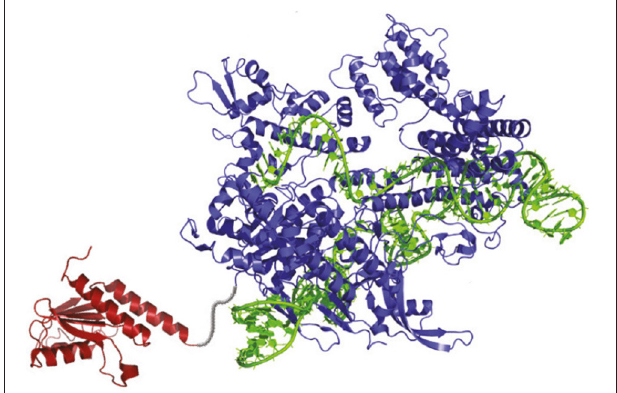
FIGURE 1 | The Structure of the Adenine Base Editor (ABE). The ABE contains an atom-rearranging enzyme (in red) that can convert adenine to inosine (read and copied as guanine), sgRNA (in green), which directs the molecule to the desired point, and a Cas9 nickase (in blue), which snips the opposing strand of DNA and tricks the cell into converting the complementary base (Gaudelli et al., 2017).